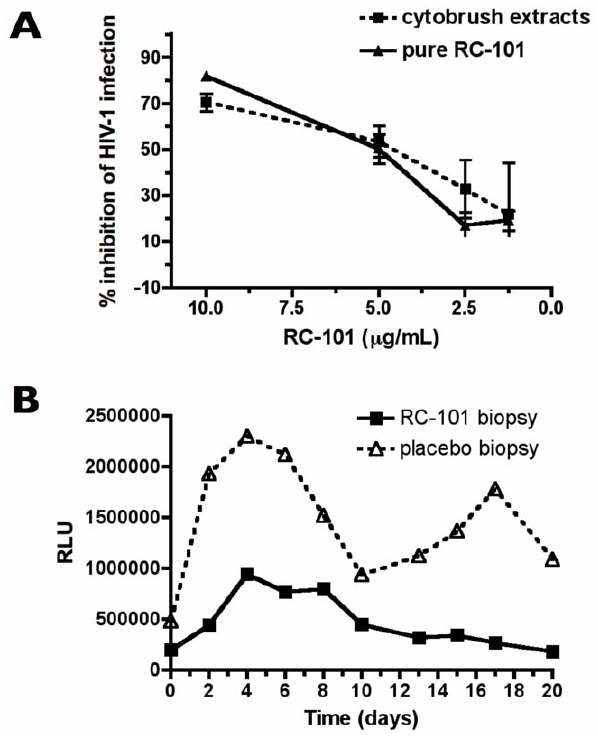
Figure 6. Presence of RC-101 in cytobrush samples from cervix and its antiviral activity in vitro and ex vivo . ( A ) Acetic acid- extracted day 5 cytobrush samples from three monkeys were assayed against HIV-1 strain BaL in a TZM-bl reporter assay, and compared to unformulated ‘‘pure’’ RC-101. No statistical differences were observed between extracted and pure RC-101 samples. ( B ) RT-SHIV replication in tissues from monkeys exposed to film formulated RC-101 or placebo film in an organ culture. The amount of virus in culture supernatant was quantified in a TZM-bl assay. Means of two tissues per condition are